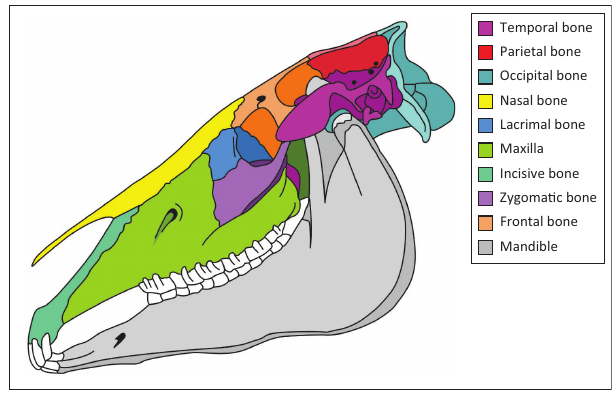
FIGURE 1: Diagrammatic representation of the equine cranium from the lateral perspective illustrating the craniofacial suture lines.